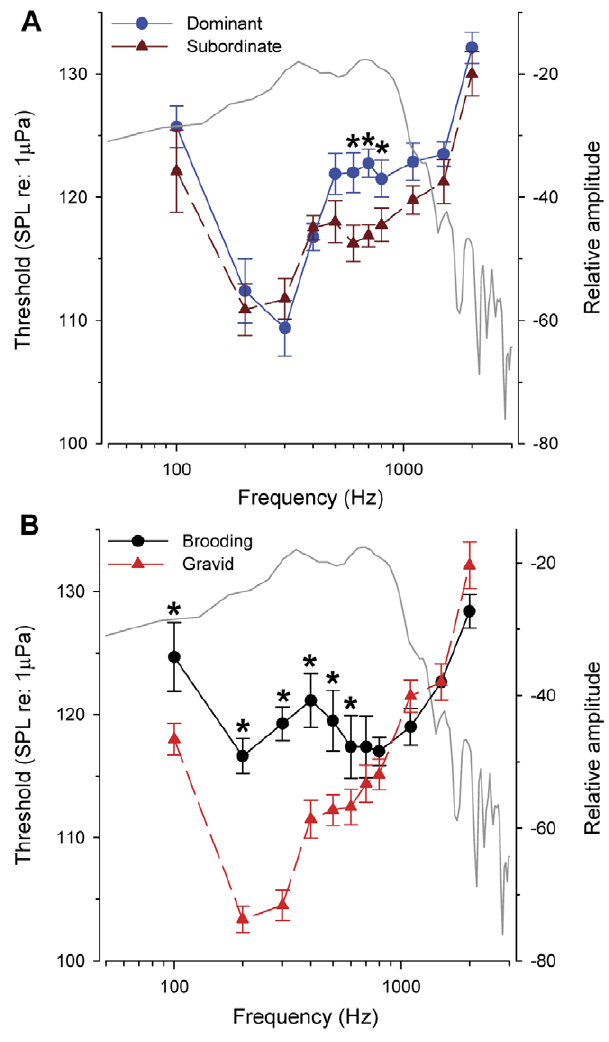
Figure 5. Hearing thresholds in the cichlid fish A.burtoni . A) Hearing thresholds for subordinate and dominant males show similar responses, but subordinate males had lower thresholds at 600–800 Hz. B) Hearing thresholds for females show that receptive gravid individuals have lower thresholds at low frequencies from 100–600 Hz compared to mouthbrooding females. Threshold data are plotted as mean 6 SE (left axis). Asterisks indicate statistical differences between reproductive states within a sex at each test frequency ( p , 0.05). Gray overlay lines represent the power spectra (128 point FFT, Hanning window) of a representative courtship sound and are plotted as relative amplitude in dB (right axis) for comparison of sound spectral energy to hearing thresholds. N =8 fish for each reproductive state (for females) and social status (for males).